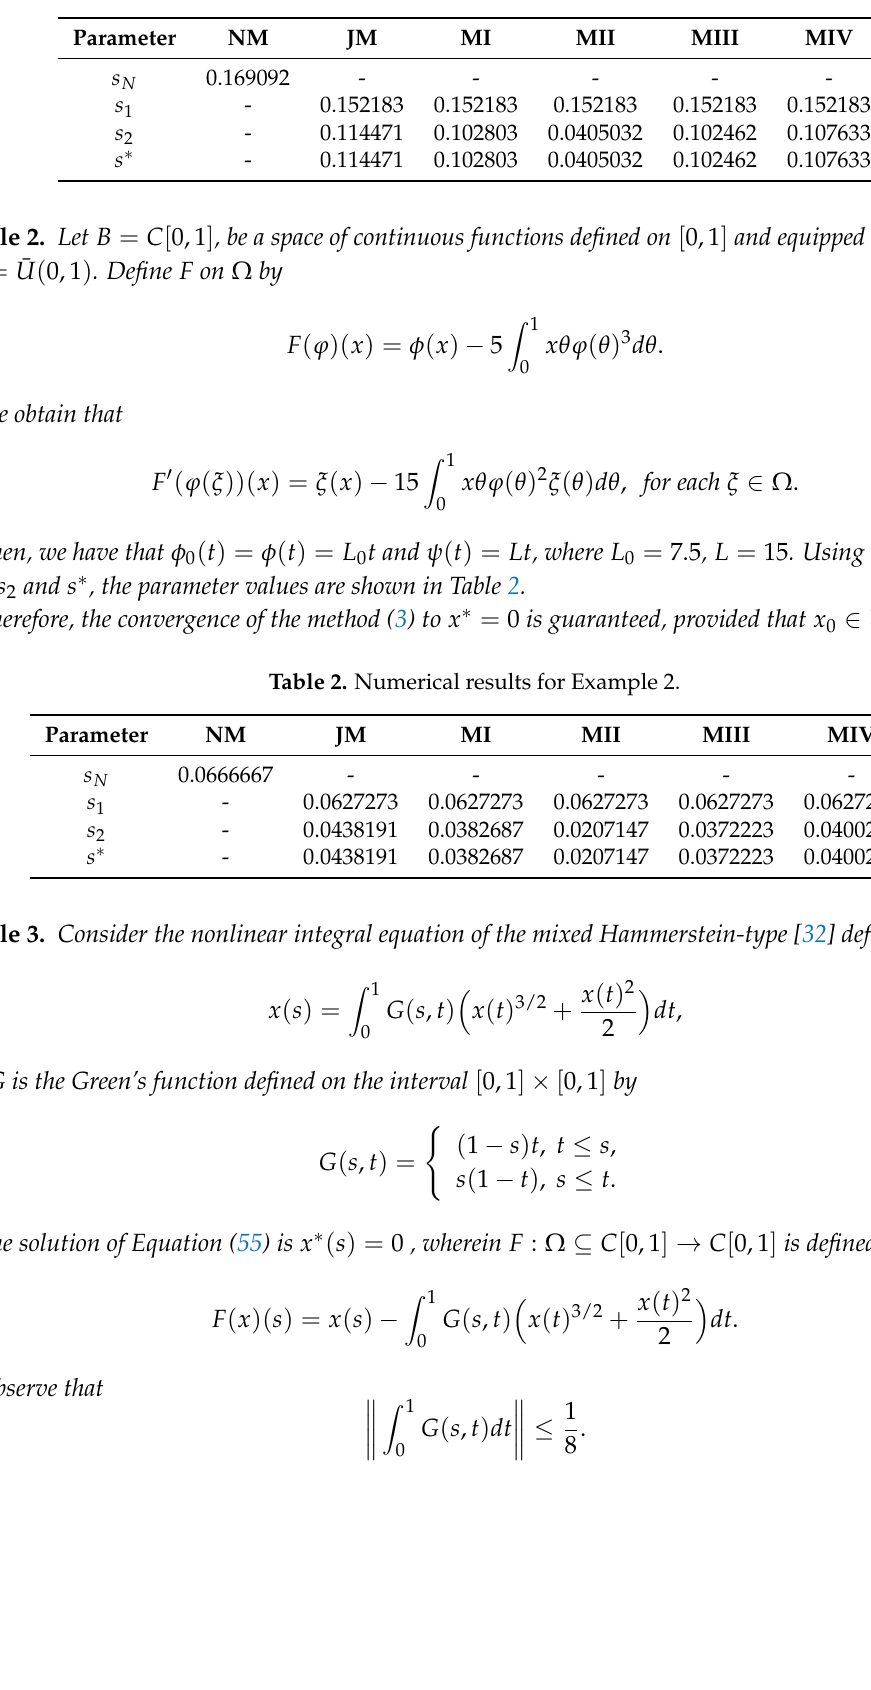
Table 1. Numerical results for Example 1.